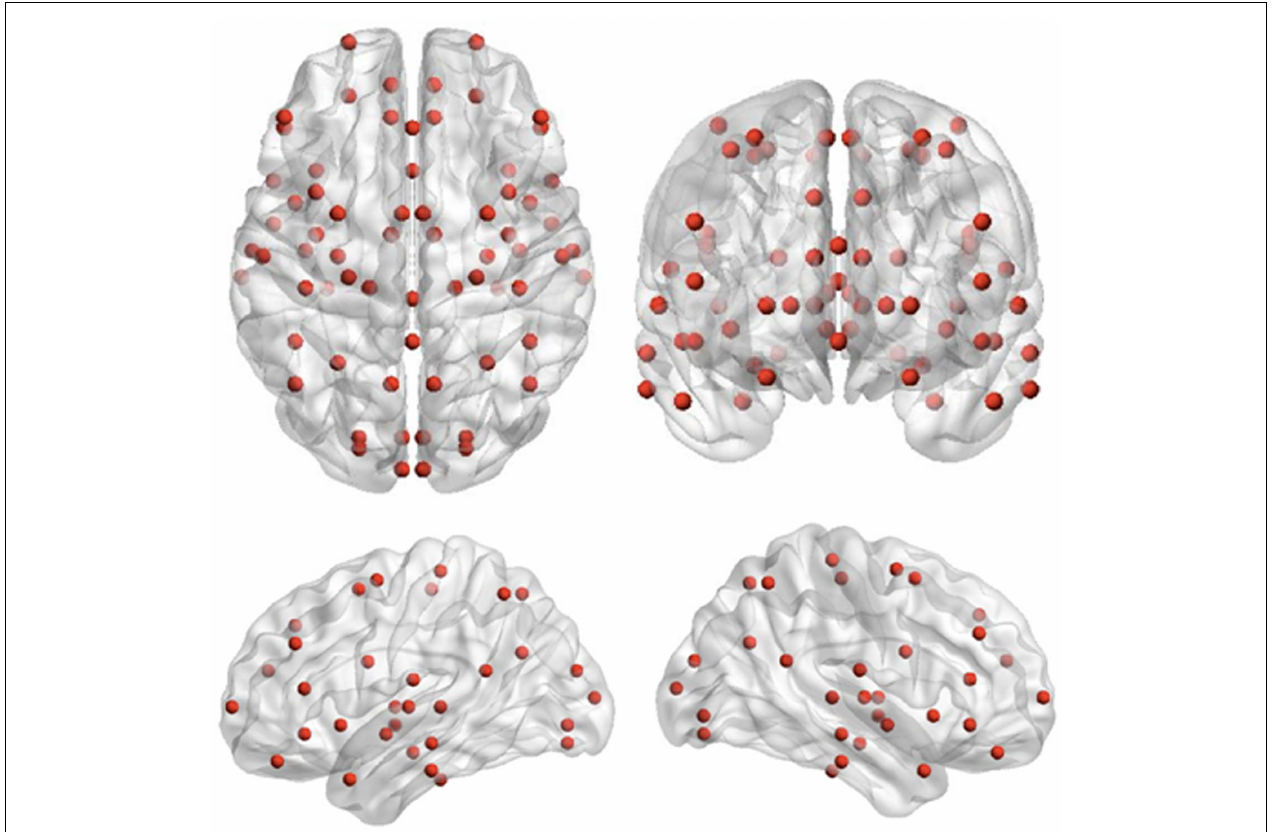
FIGURE 2 | Seed locations for the inter-regional phase-locking analysis . Seed locations are the 72 cortical and sub-cortical regions originally adapted for source-space MEG analysis by Diaconescu et al.